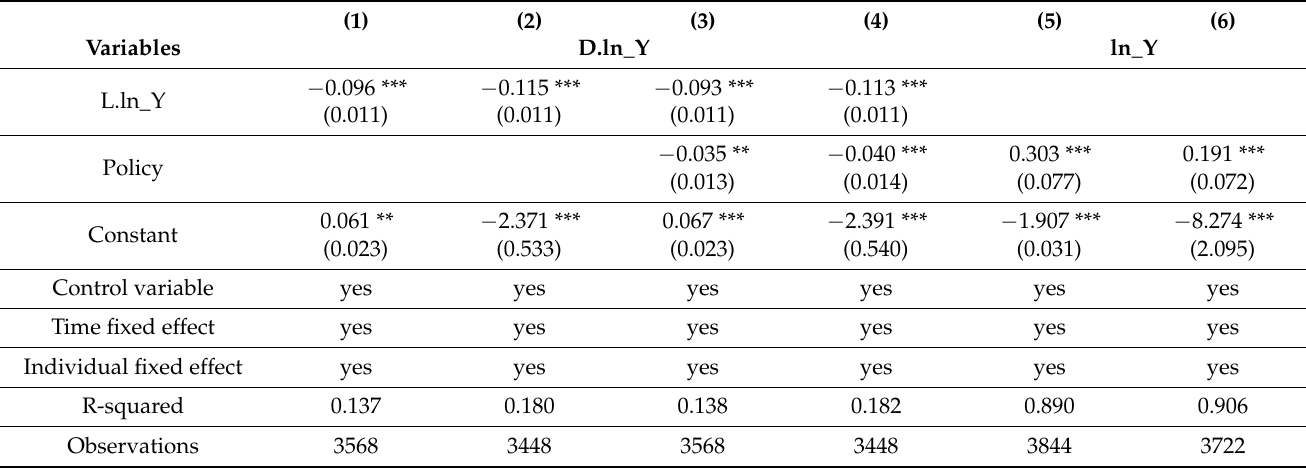
Table 1. Benchmark regression